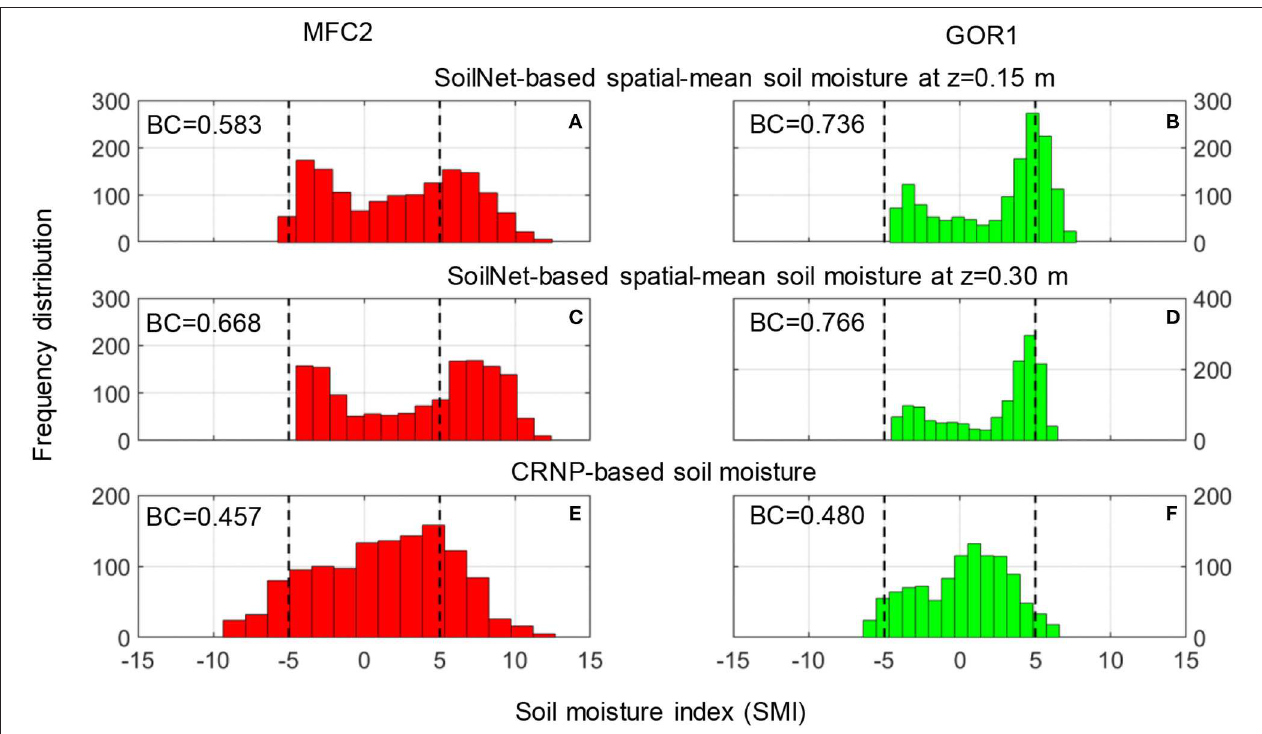
FIGURE 8 | Frequency distributions of daily values of SMI (SMI d ) calculated using SoilNet-based soil moisture spatial-mean at z and z 0.30m at (C) MFC2 and (D) GOR1, and CRNP-based soil moisture at (E) MFC2 and (F) GOR1. Each subplot reports the bimodality coefficient =